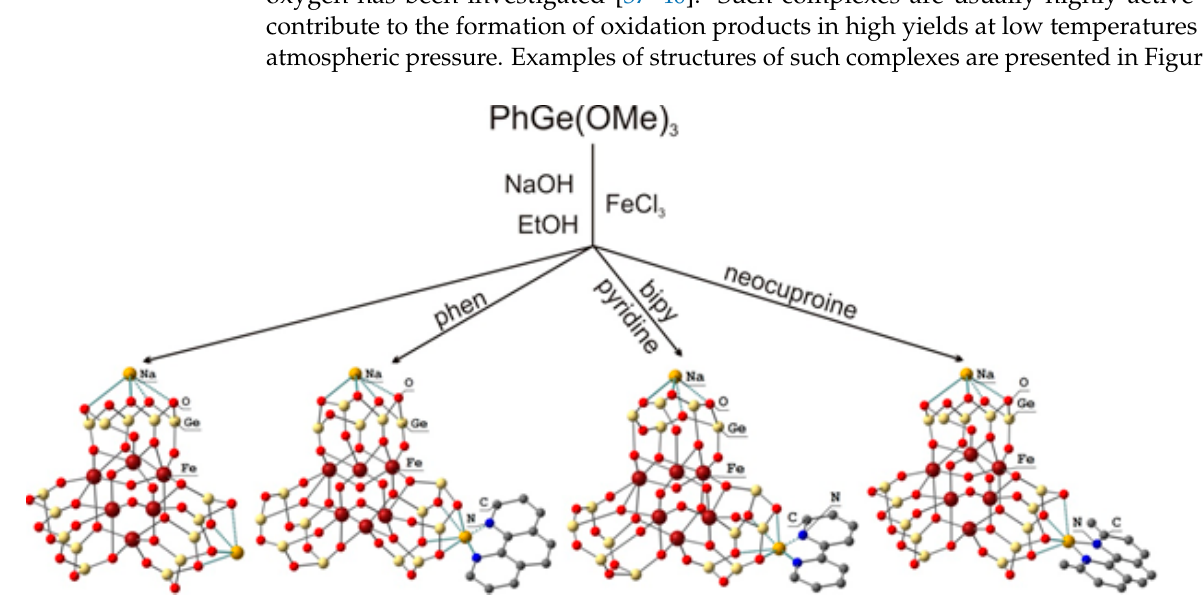
Figure 3. All structures adapted from Ref. [40], Copyright (2016) with permissions of Wiley.